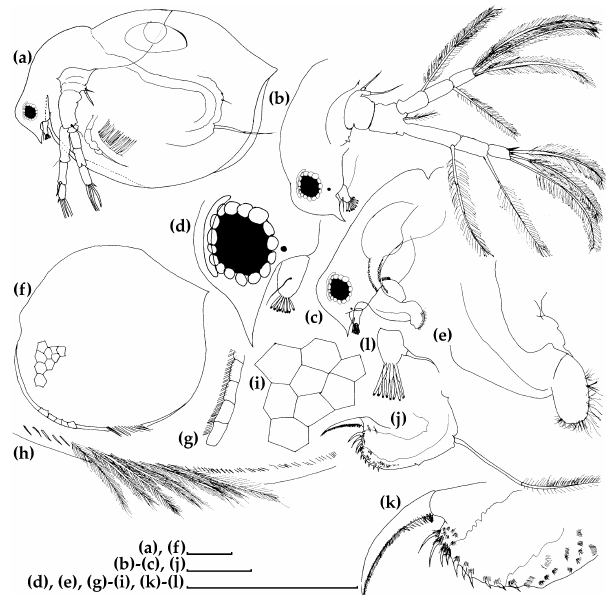
Figure 2. Ceriodaphnia cf. cornuta , an adult parthenogenetic female from Masfoot Dam 1, United Arab Emirates. ( a ) Female, lateral view; ( b – d ) head, lateral view; ( e ) labrum; ( f ) valve, lateral view; ( g ) armature of posterior margin of valve, inner view; ( h ) armature of ventral margin of valve, inner view; ( i ) ornamentation of lateral portion of valve, outer view; ( j ) postabdomen; ( k ) postabdominal claw; ( l ) antenna I; All scale bars: 0.1 mm.